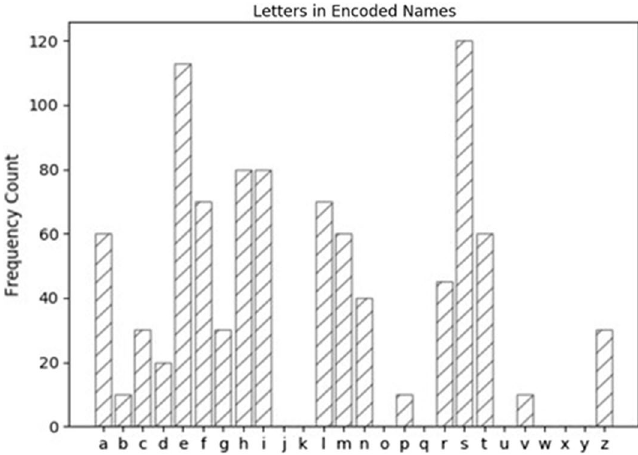
Fig. 11 Frequency analysis of ’Name’ attribute after privacy